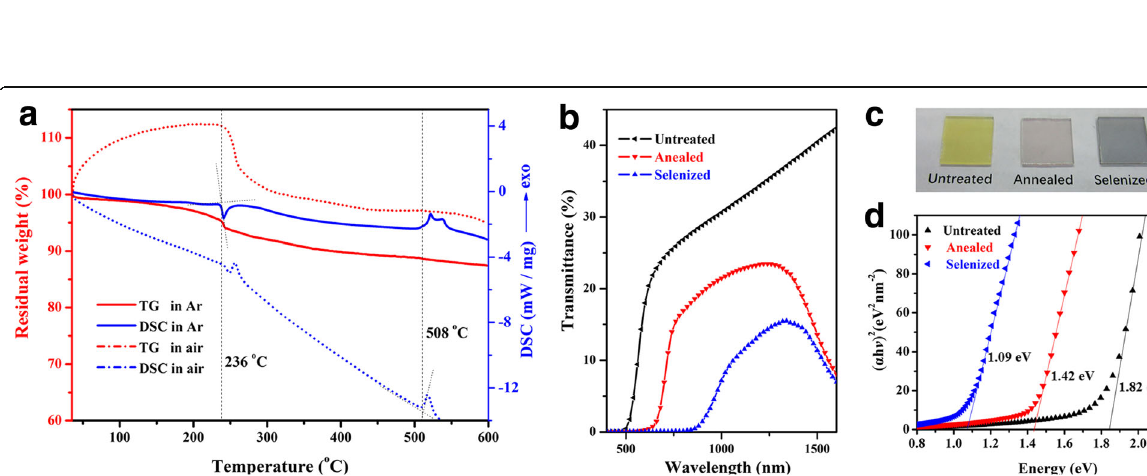
Fig. 3 Photoelectric properties of Sb 2 S 3 QD thin films. a TG and DSC profiles of dried Sb 2 S 3 QDs tested in Ar and air. b Transmittance spectrum, c a photograph, and d band gap analysis of pre- and post-annealed Sb 2 S 3 QD thin